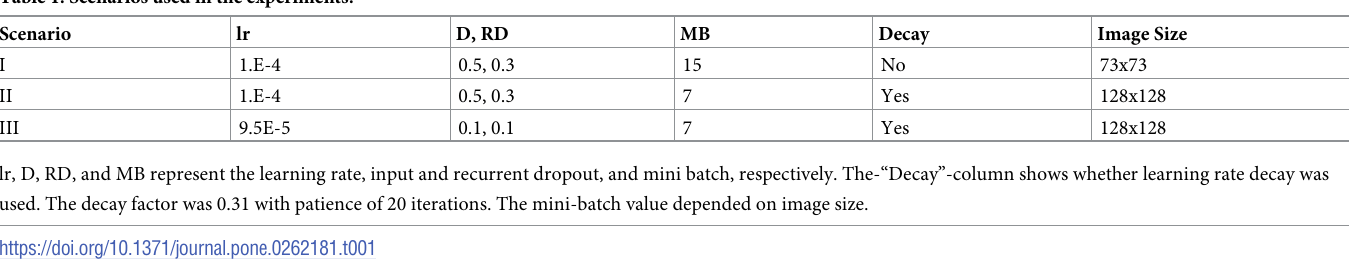
Table 1. Scenarios used in the